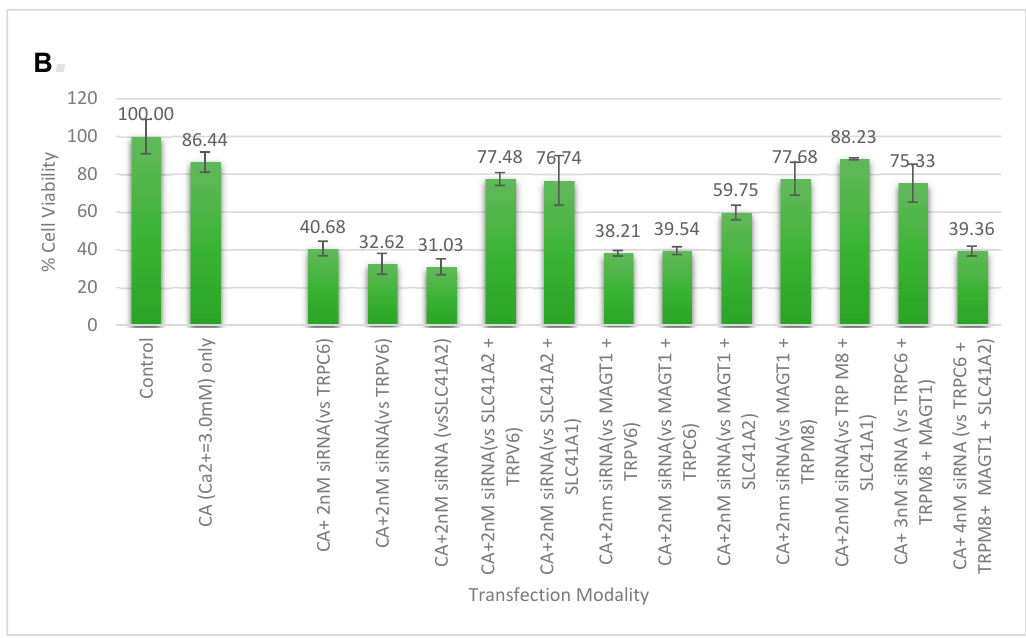
Figure 9. CA-multiple siRNAs to determine synergistic cytotoxicity: ( A ) MCF-7 cells; ( B ) 4T1 cells. Cell viability assessment in breast cancer cells for the NP-siRNA formed with a fixed concentration of exogenous CaCl 2 . Cells were treated with media (untreated), NPs formed with 3 mM (for 4T1) and 4 mM (for MCF-7) of exogenous CaCl 2 , and different combinations of NP-siRNA formed with 1 nM of individual siRNA. After 44 h of treatment, cell viability was measured by MTT assay. Values are represented as the mean % of cell viability ± SEM, when compared to untreated cells, where N = 3. We infer that this is probably because there are more than one type of calcium or magnesium channels for the cells, thus the knockdown of a group of these proteins is necessary to produce a robust effect. As the greatest synergistic effect was seen when a magnesium transporter (MAGT1)